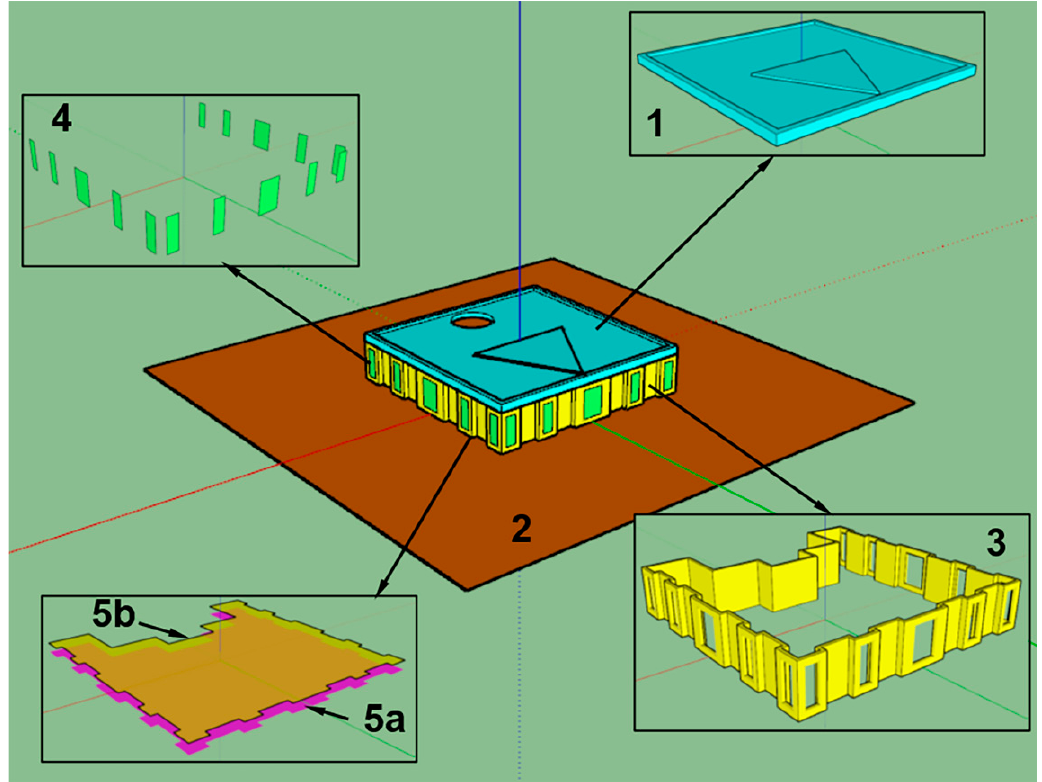
Figure 7. SketchUp model for comparison with DL-Light.